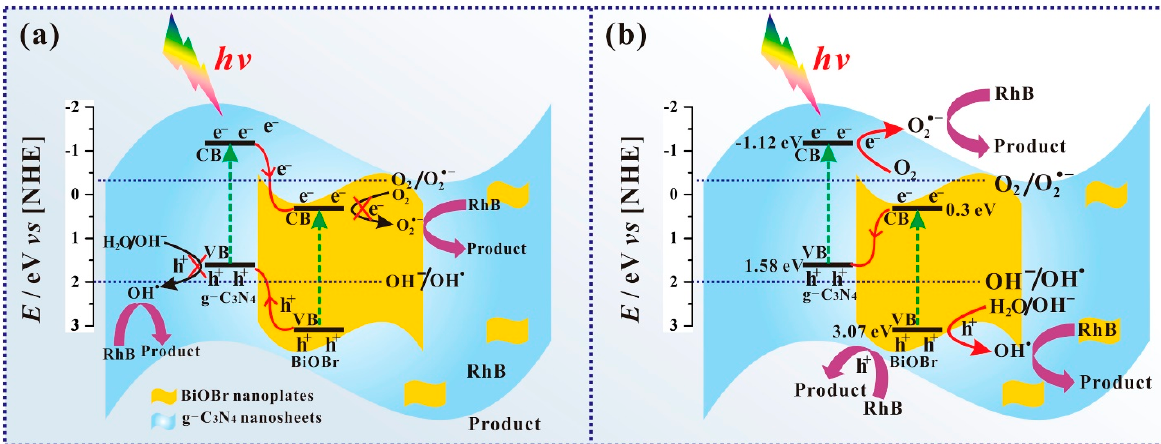
Figure 12. Schematic depicting ( a ) type-II heterojunction and ( b ) Z-scheme system, the two possible photocatalytic charge transfer processes in the heterojunction between BiOBr nanoplates and g-C 3 N 4 nanosheets under visible light irradiation. Reprinted from Ref. [123] with permission from Elsevier.